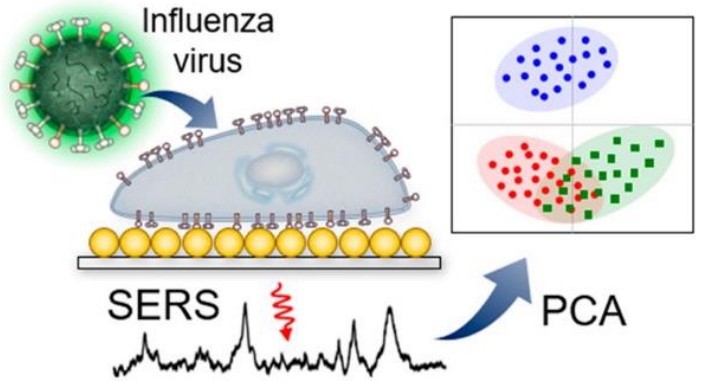
Figure 1. Label-free identification of cells infected with different influenza viruses based on SERS with further principal component analysis (PCA). Reproduced with permission from [43]. Copyright American Chemical Society, 2019.